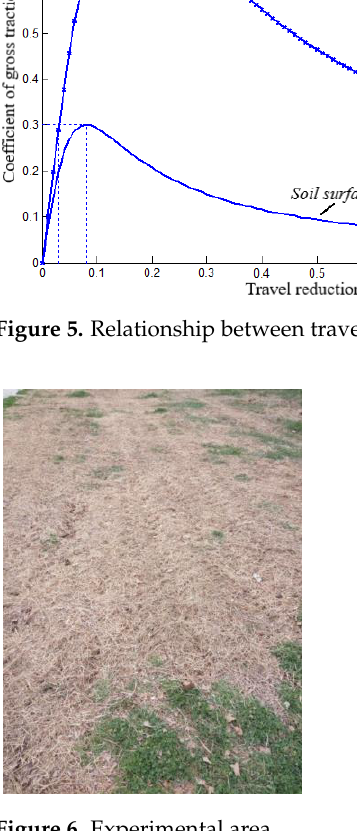
Figure 6. Experimental area.